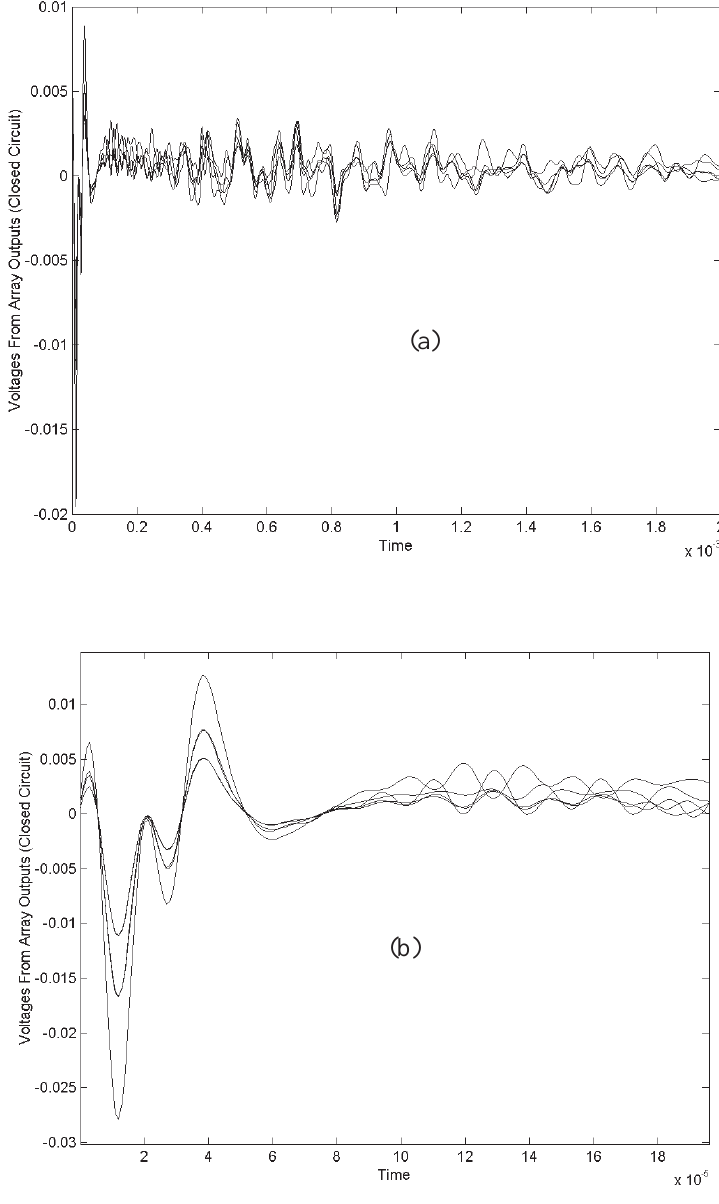
Fig. 6. Voltage time history due to center actuation by a PZT patch; (a) array voltage for 2 ms, (b) array voltage for 0.2 ms. in displacement form